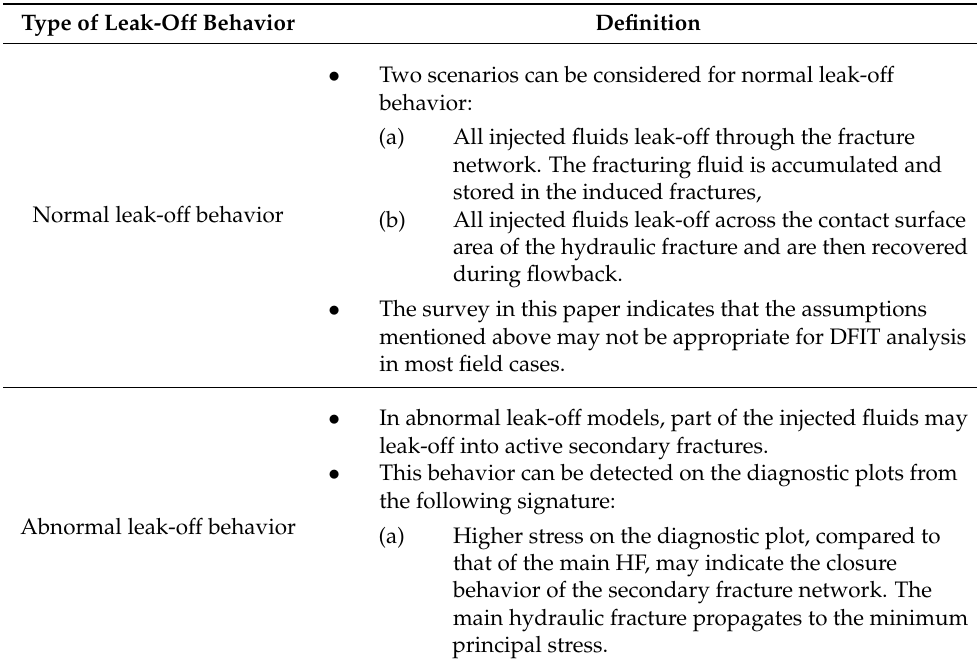
Table 5. Definition of two main leak-off behaviors.